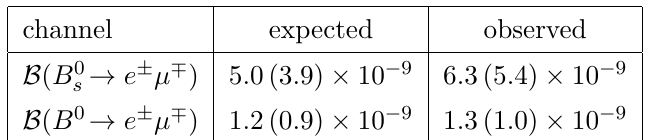
Table 2 . Expected (assuming no signal) and observed upper limits for B ( B 0 e (cid:6) (cid:22) (cid:7) ) at 95% (90%) CL. The upper limit on the B ( B 0 of pure heavy eigenstate contribution on the decay